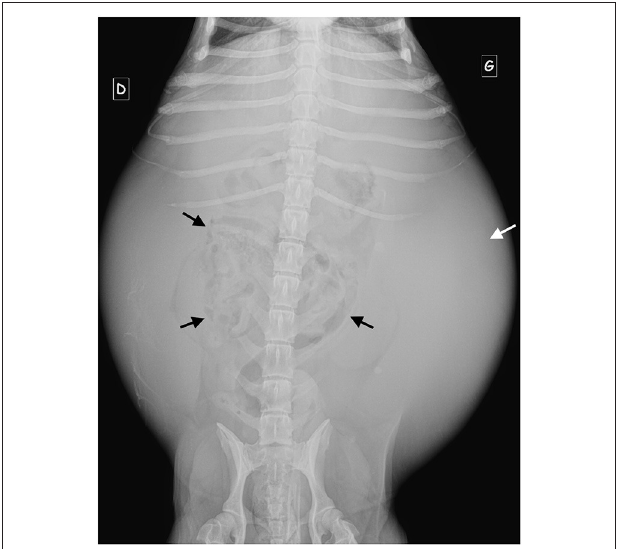
FIGURE 1 | Ventro-dorsal radiograph of D6. Note the severely increased abdominal volume, the central gathering of the small bowel loops (black arrows) with fluid opacity at the periphery of the peritoneal cavity (white arrow).